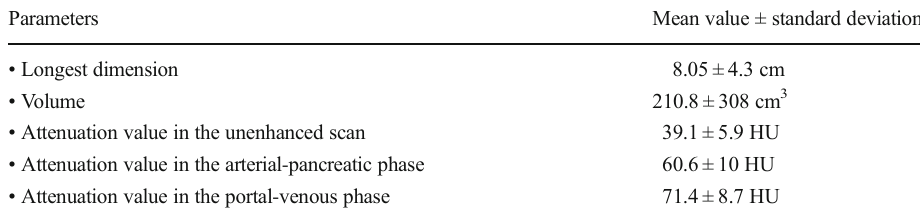
Table 4 Results of the quantitative analysis